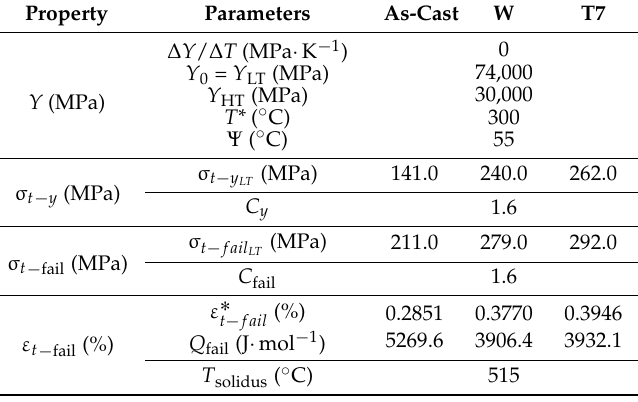
Table 1. Experimental and empirical model parameters for Al ‐ A319 alloys in various heat treatment conditions. Experimental and empirical model parameters for Al-A319 alloys in various heat treatment